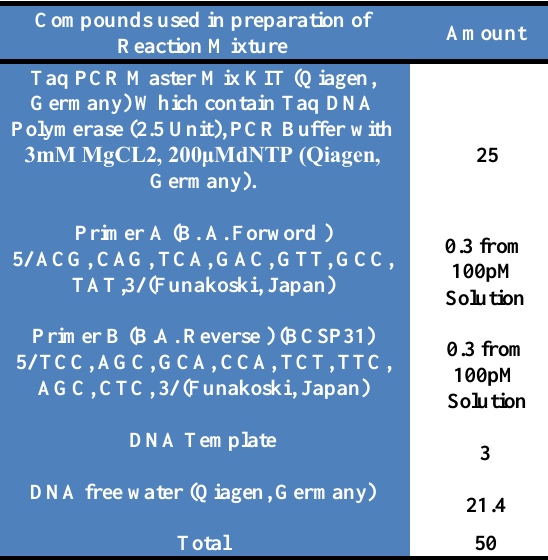
Table, 1: Compounds used in preparation of Reaction Mixture.